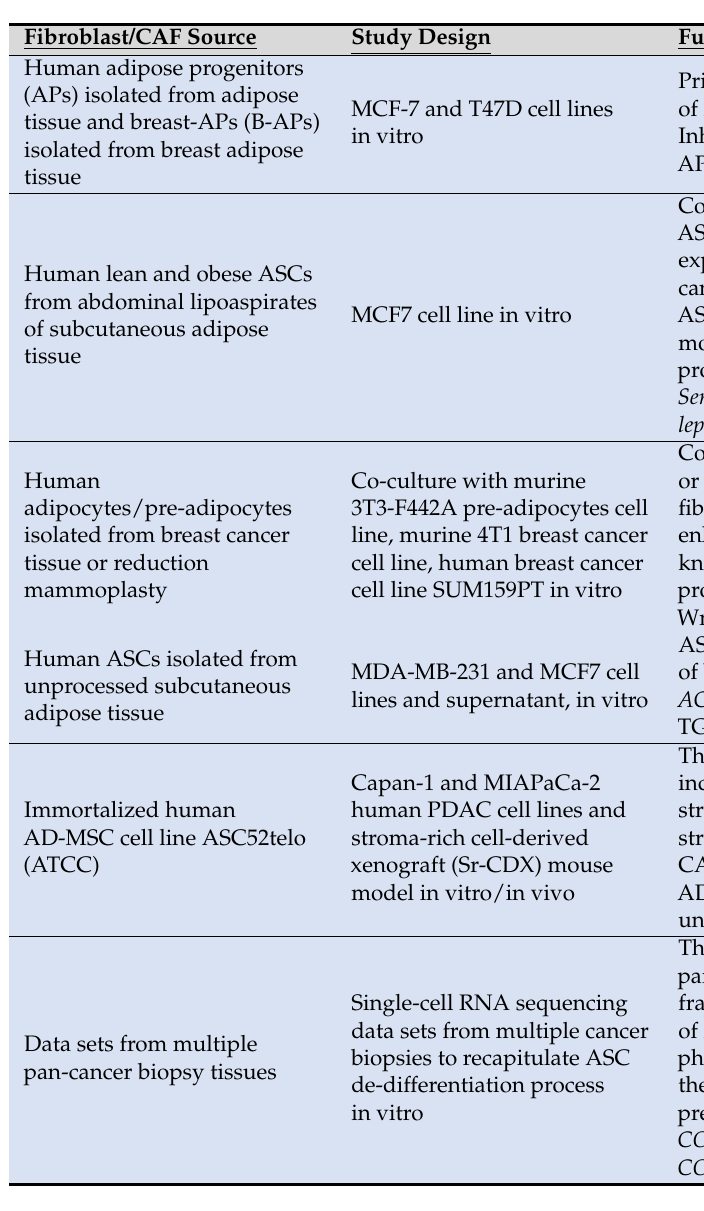
Table 3. Subtypes of cancer associated ASCs/CAFs in breast